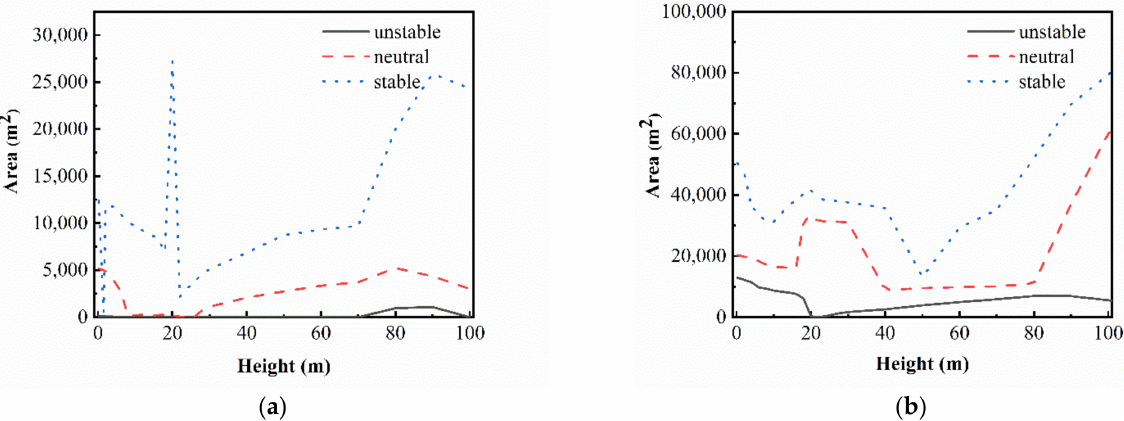
Figure 11. Areas of each concentration interval of SF 6 under different heights at 20:40 LST on August 9: ( a ) CONC ∈ [150 ppb, 200 ppb]; ( b ) CONC ∈ [300 ppb, + ∞ ).